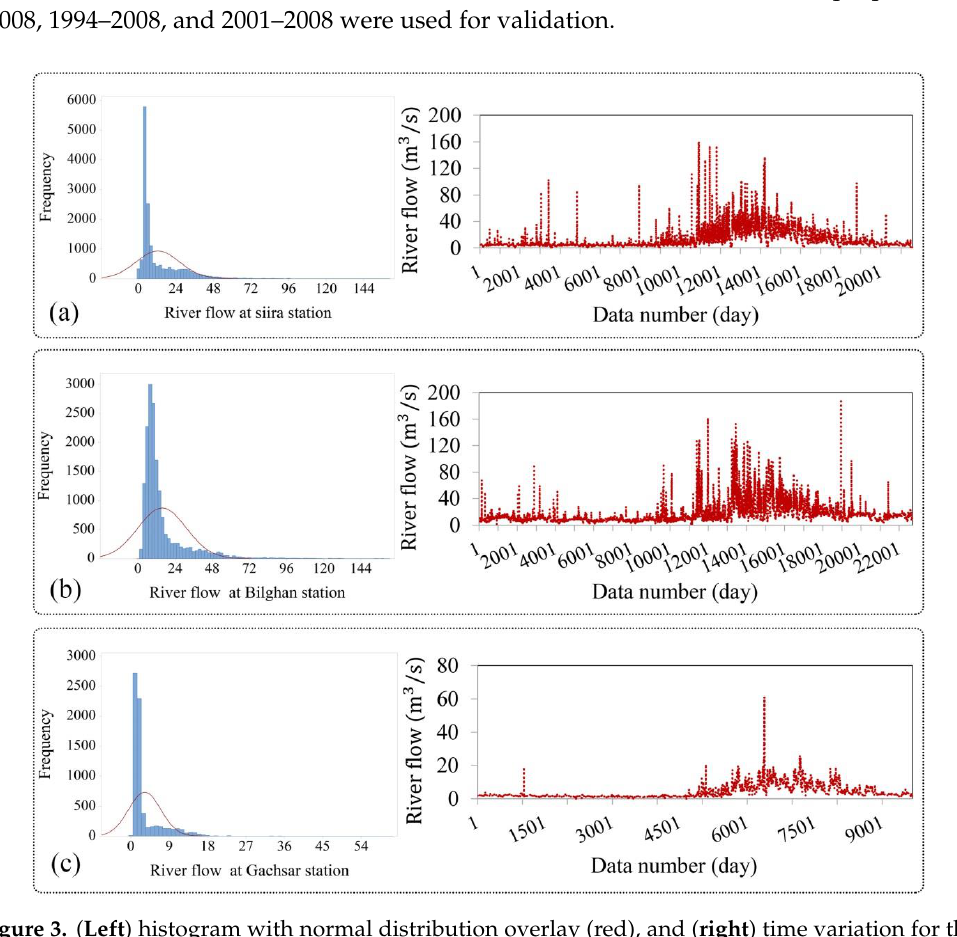
Figure 3. ( Left ) histogram with normal distribution overlay (red), and ( right ) time variation for the observed river flows; ( a ) Siira station, ( b ) Bilghan station, and ( c ) Gachsar station.